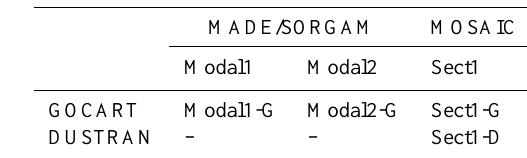
Table 1. WRF-Chem